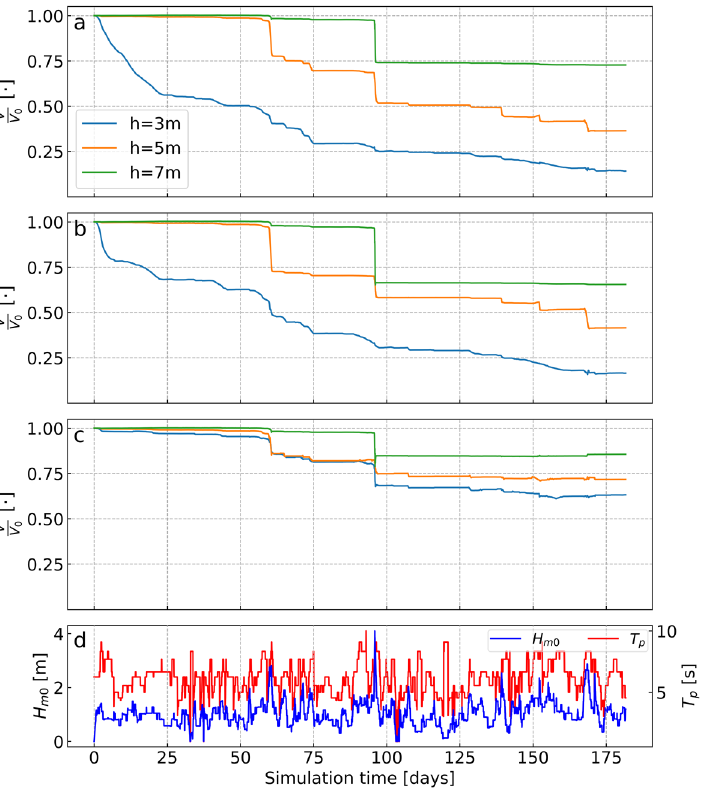
Figure 12. Longevity of nearshore nourishments at South Padre Island site in terms of percent placed volume remaining in original footprint through time where the blue, orange, and green colors represent the 3 m, 5 m, and 7 m placement depths, respectively. ( a ) Linear berm; ( b ) undulated berm; ( c ) discrete mounds; ( d ) time series of offshore zero-moment wave height and peak period.